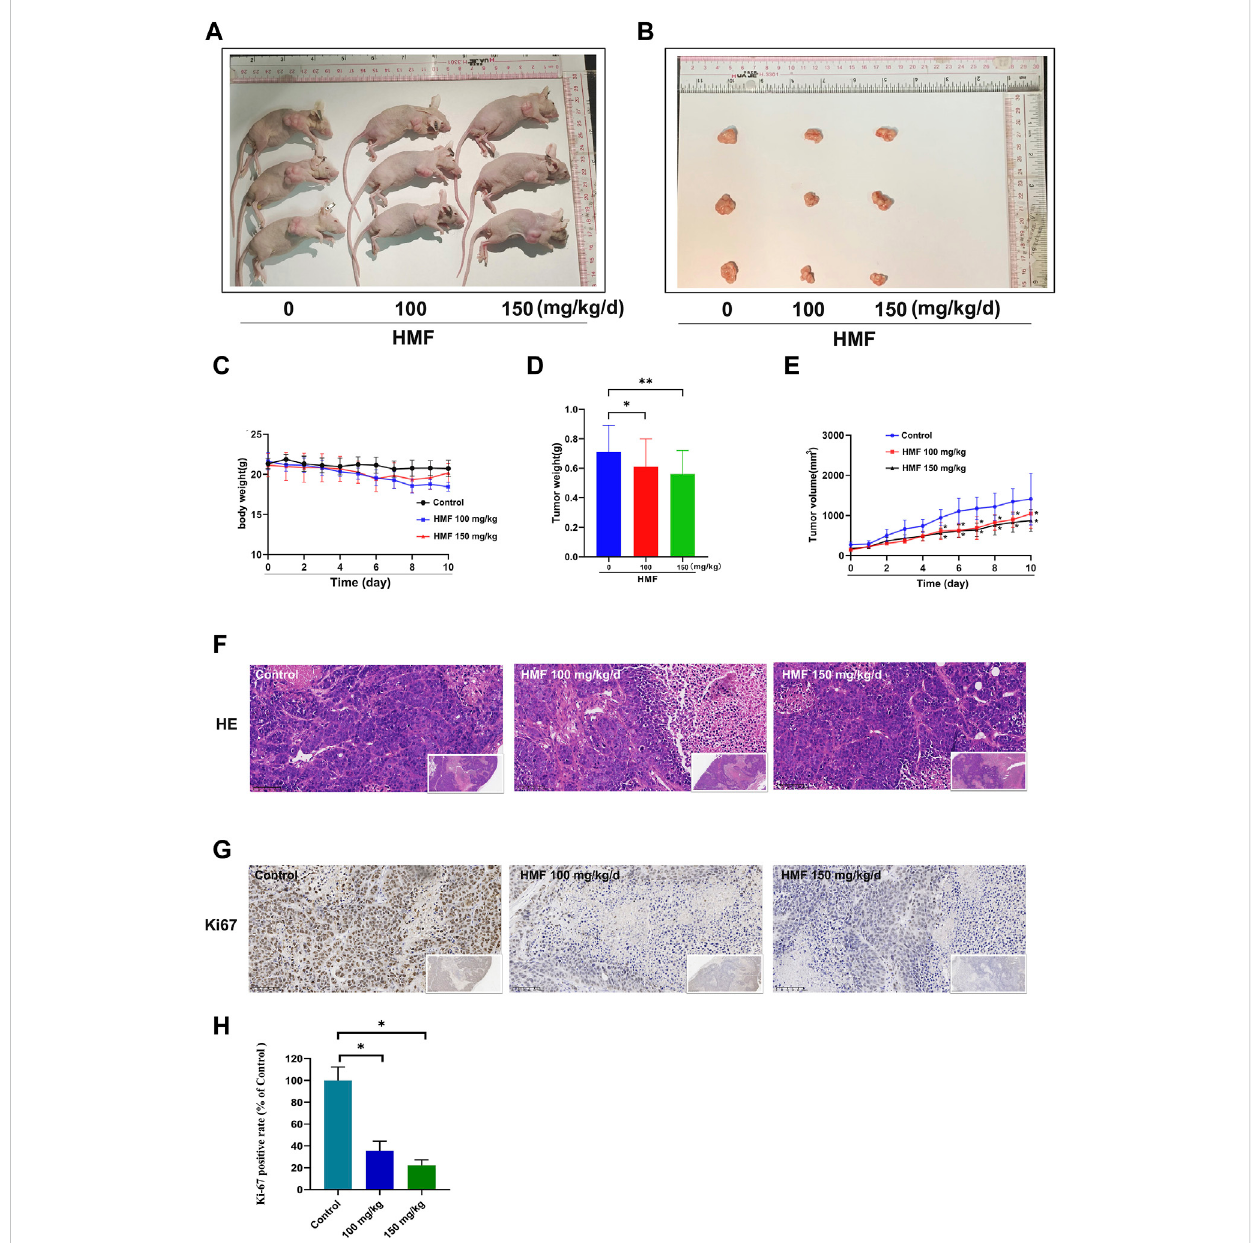
FIGURE 6 HMF inhibits NPC tumor growth and promotes tumor cell death in nude mice. (A,B) NPC tumors of nude mice. (C) Daily body weight variation in tumor-bearingnudemiceinthecontrolandHMFtreatmentgroups. (D) Weightand (E) volumechangesofimplantedtumorsfor10days. (F) H&Estaining of tumor tissues from each treatment group (400×). (G) Ki-67 staining was conducted to detect NPC cell proliferation. (H) Quanti fi ed analysis of Ki-67 positivity rate (%) and AMPK expression (%). All data are described as the mean ± SD of three independent and repeated experiments. Compared to the control group (0 μ M): * p < 0.05; ** p < 0.01; ns, not signi fi